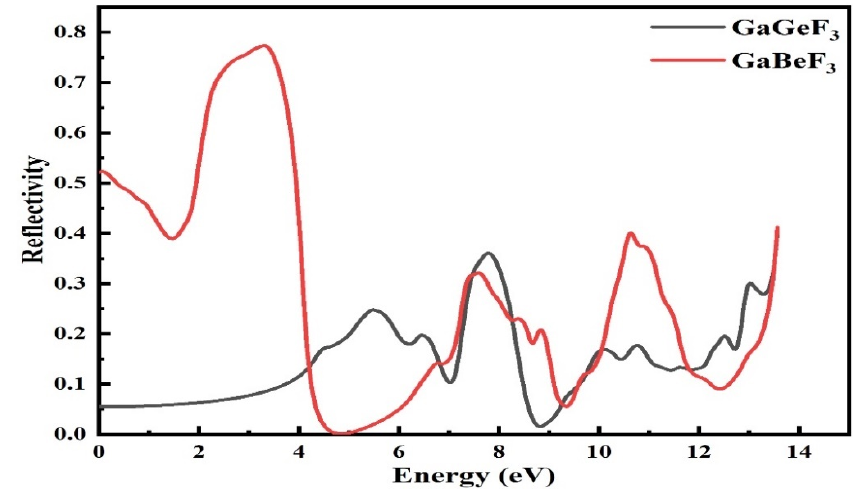
Figure 8. The computed reflectivity R( ω ) of light from the GaMF 3 compound (M = Ge and Be).